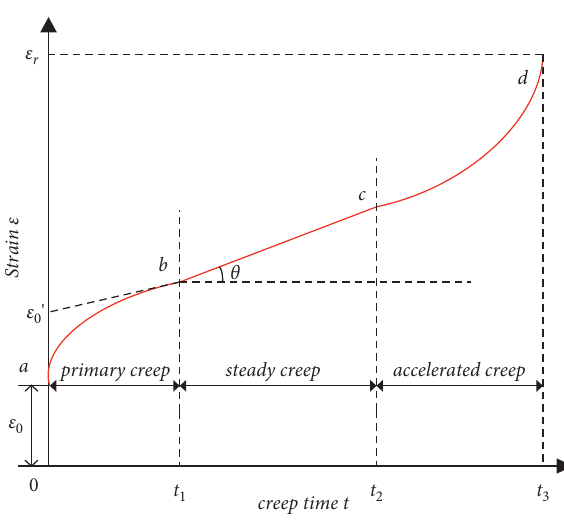
Figure 6: Classical creep